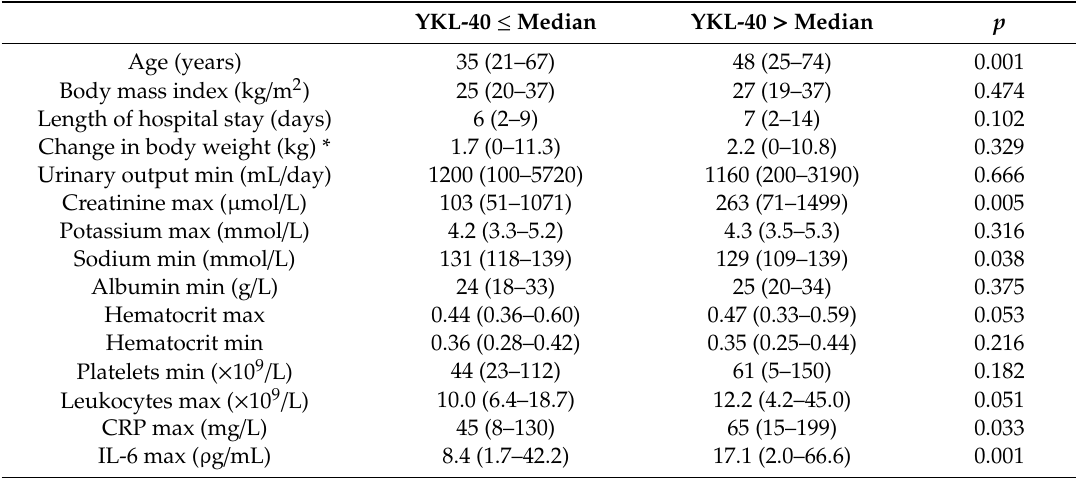
Table 3. Comparisons of clinical and laboratory findings in 79 patients with Puumala hantavirus infection divided into two groups according to YKL-40